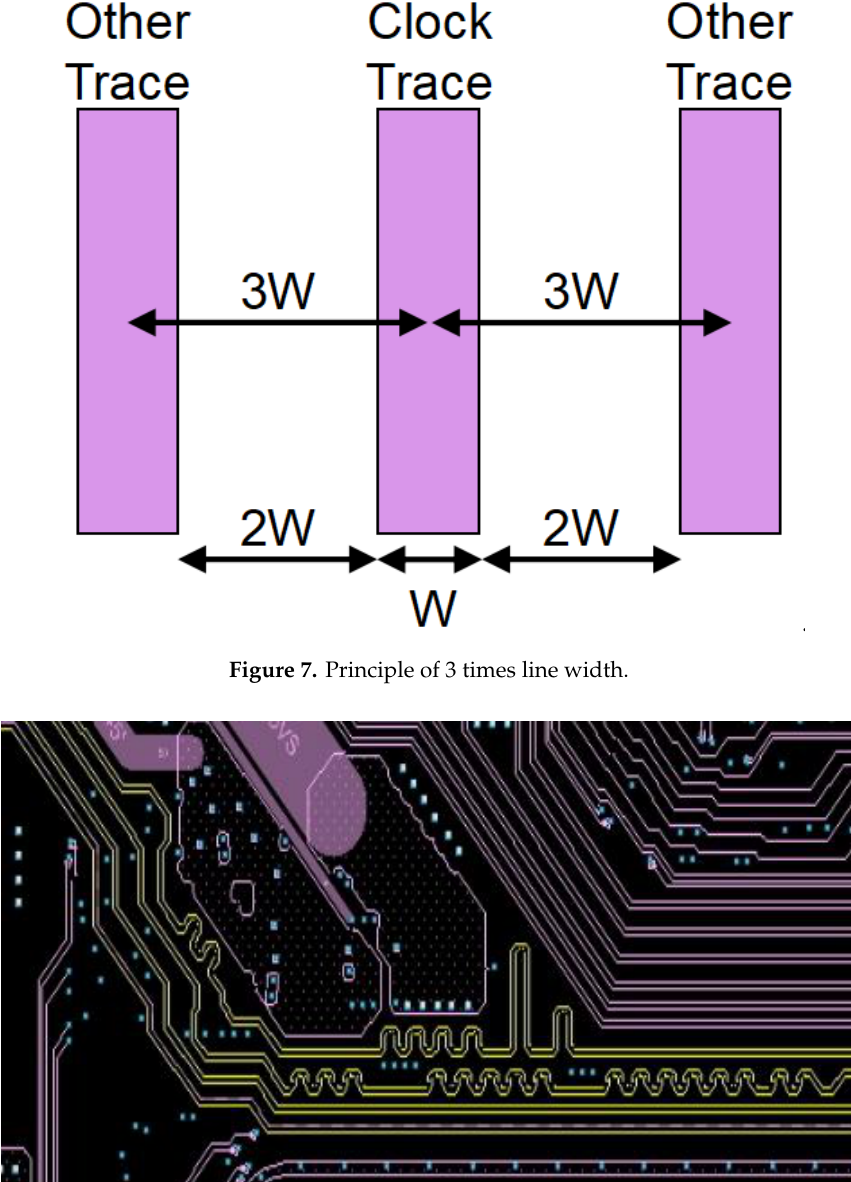
Figure 8. Schematic diagram of snake route.